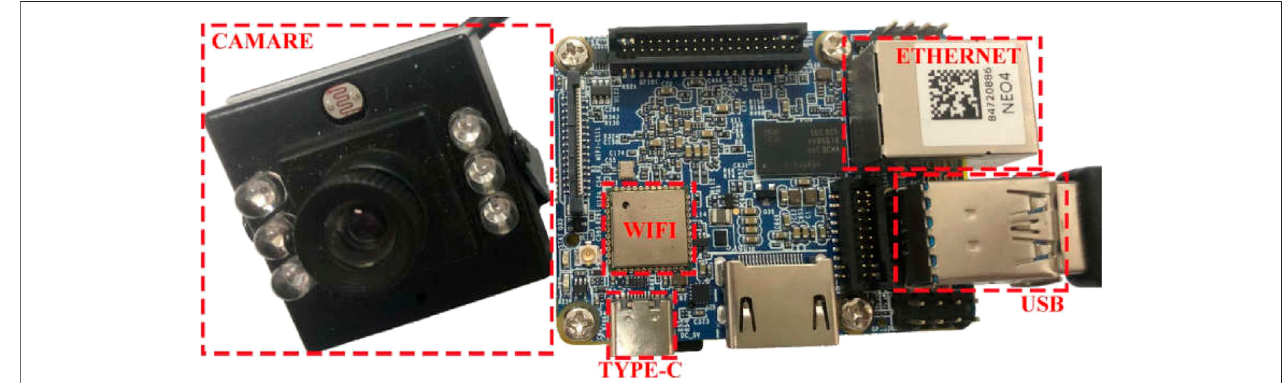
TABLE 2 | | Comparison of the running time of the algorithm in different platforms.